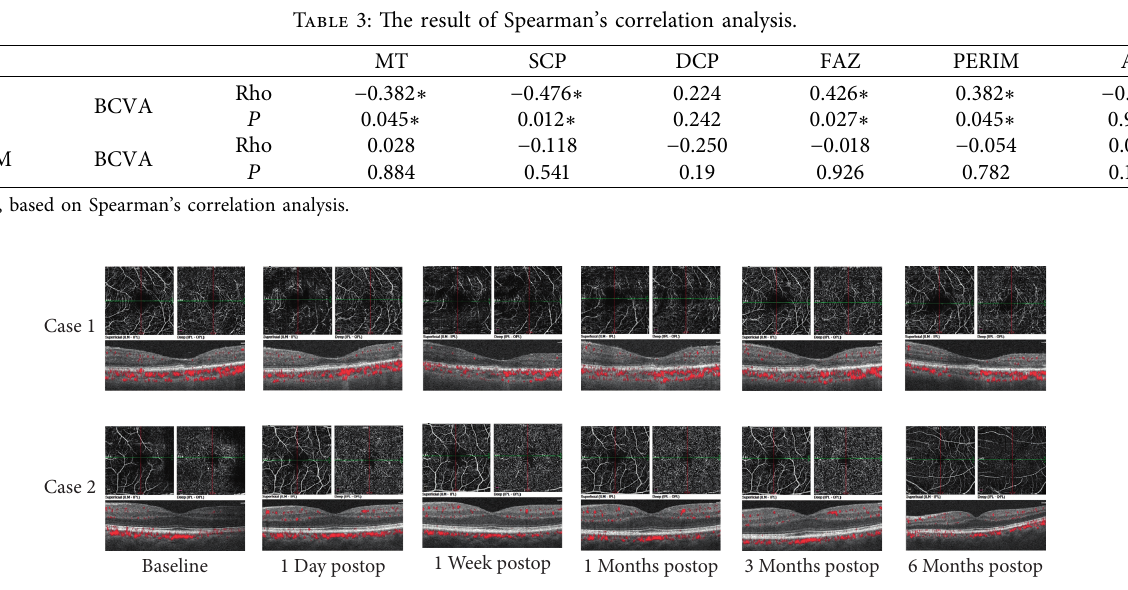
Figure 3: SCP, DCP, and MT images of 2 cases in the diabetic group at baseline, 1 day, 1 week, 1 month, 3 months, and 6 months after cataract